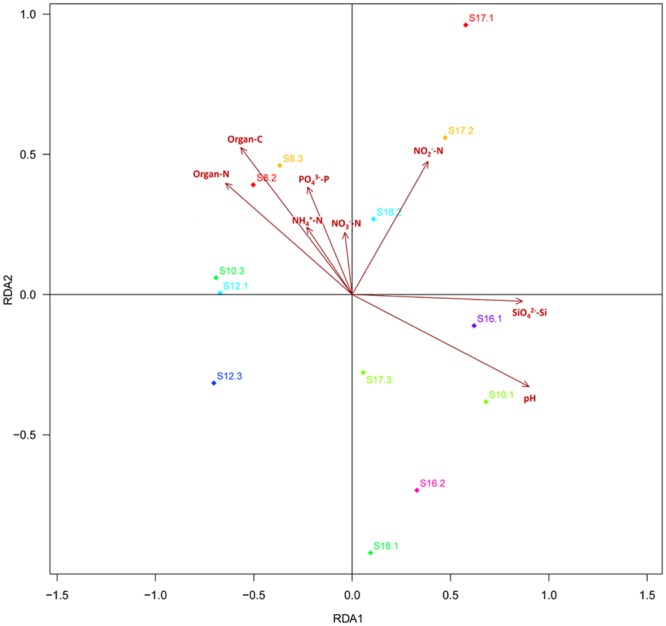
The db-RDA diagram showing the relationship between the soil properties and fungal community composition. The thirteen soil samples are labeled with a unique sampling code. Rectangles represent different soil properties.